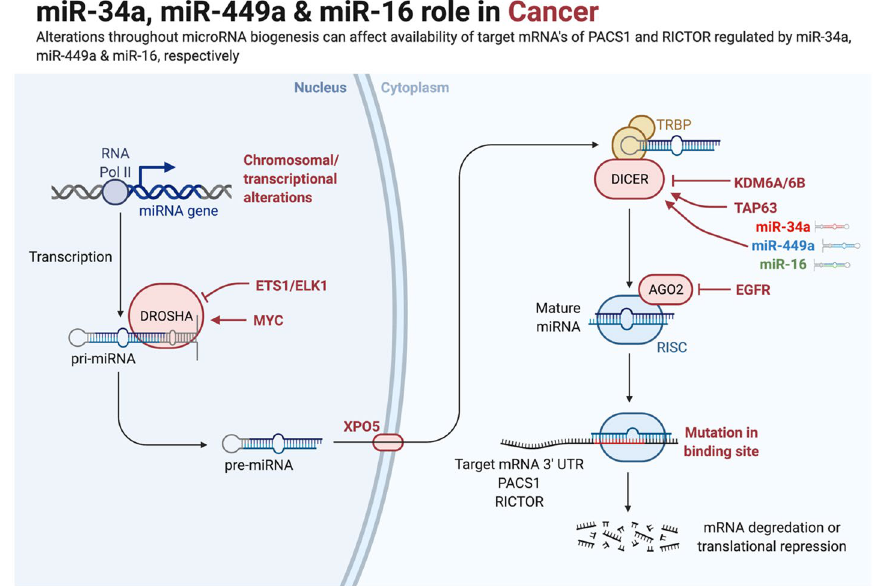
Figure 1. Schematic illustration depicting the role of microRNAs (miR-34a, miR-449a, and miR-16) in Cancer. Alterations throughout miRNA biogenesis can affect the availability of target mRNA of PACS1 and RICTOR regulated by miR-34a, miR-449a, and miR-16, respectively. miRNA genes are transcribed by RNA polymerase II to produce the large primary transcripts pri-miRNAs. The pre-miRNAs are processed by another RNase III enzyme Dicer to a ~ 20–22-nucleotide miRNA/miRNA* duplex. After the duplex is unwound, the mature miRNA is incorporated into a protein complex termed RISC. A miRNA-loaded RISC mediates gene silencing via mRNA cleavage and degradation on the complementarity between the miRNA and the targeted mRNA transcript. In addition, miRNAs may function as ligands to directly bind with Toll-like receptors (TLR), triggering downstream signaling pathways. Methyltransferase-like 3 (METTL3) is recently discovered to methylate pri-miRNAs, marking them for recognition and processing by DGCR to yield mature